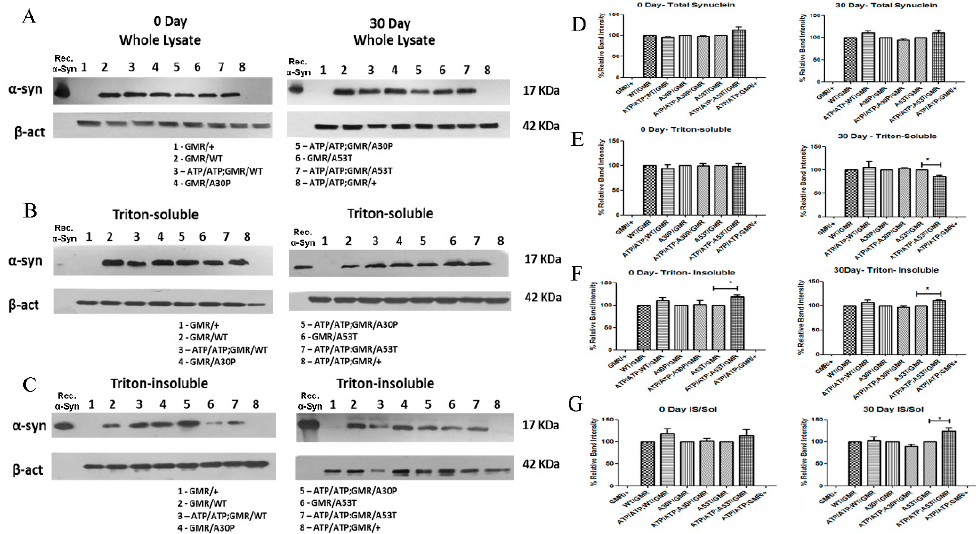
Figure 3. Effect of ATP13A2 silencing on α -syn protein expression and accumulation. Immunoblotting was performed using the whole-tissue lysis extraction method with fly heads ( A ), and densitometric analysis of the immunoblots revealed no accumulation of WT, A30P, or A53T α -syn during ATP13A2 silencing under GMR-Gal4 drive compared to control flies expressing α -syn alone ( D ). Triton-soluble α -syn levels in ATP13A2 RNAi flies expressing WT, A30P, and A53T syn were analyzed by Western blotting of day 0 and day 30 fly heads ( B ). The corresponding densitometric graph where ATP13A2 RNAi flies expressing WT, A30P, and A53T syn were normalized to 100% of the respective controls (GMR with α -syn) is shown ( E ). Triton-insoluble α -syn levels in ATP13A2 RNAi flies expressing WT, A30P, and A53T syn were analyzed by Western blotting of heads from day 0 and day 30 flies ( C ). The corresponding densitometric graph ( F ). Ratio of syn in the triton-insoluble to soluble fraction of Day 0 and Day 30 samples ( G ). The graph represents the mean ± S. E. M for three independent experiments. Differences in means were compared by one-way ANOVA followed by the Newman–Keuls Multiple Comparison post hoc test. * p < 0.05.